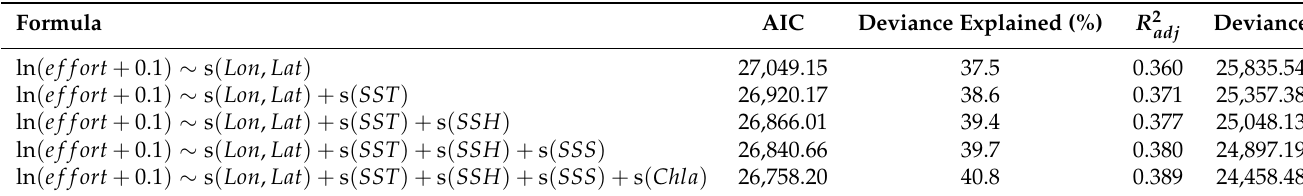
Table 1. Statistical parameters of GAM model.